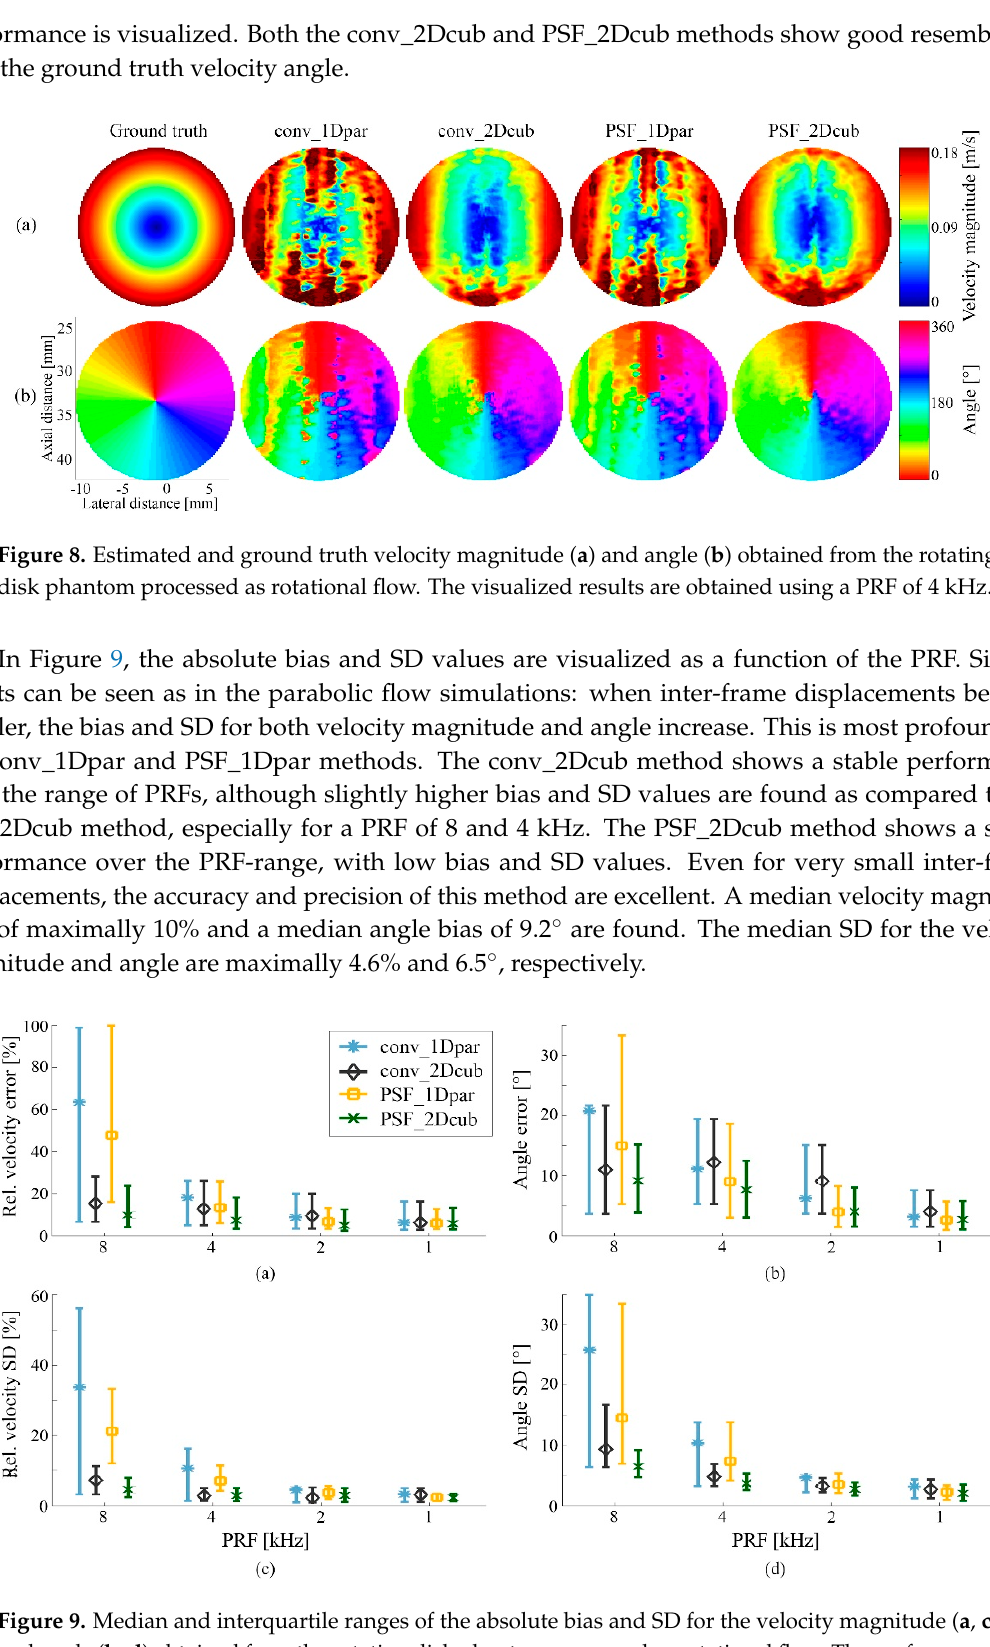
Figure 9. Median and interquartile ranges of the absolute bias and SD for the velocity magnitude ( a , c ) and angle ( b , d ) obtained from the rotating disk phantom processed as rotational flow. The performance of the methods is visualized as a function of the PRF.